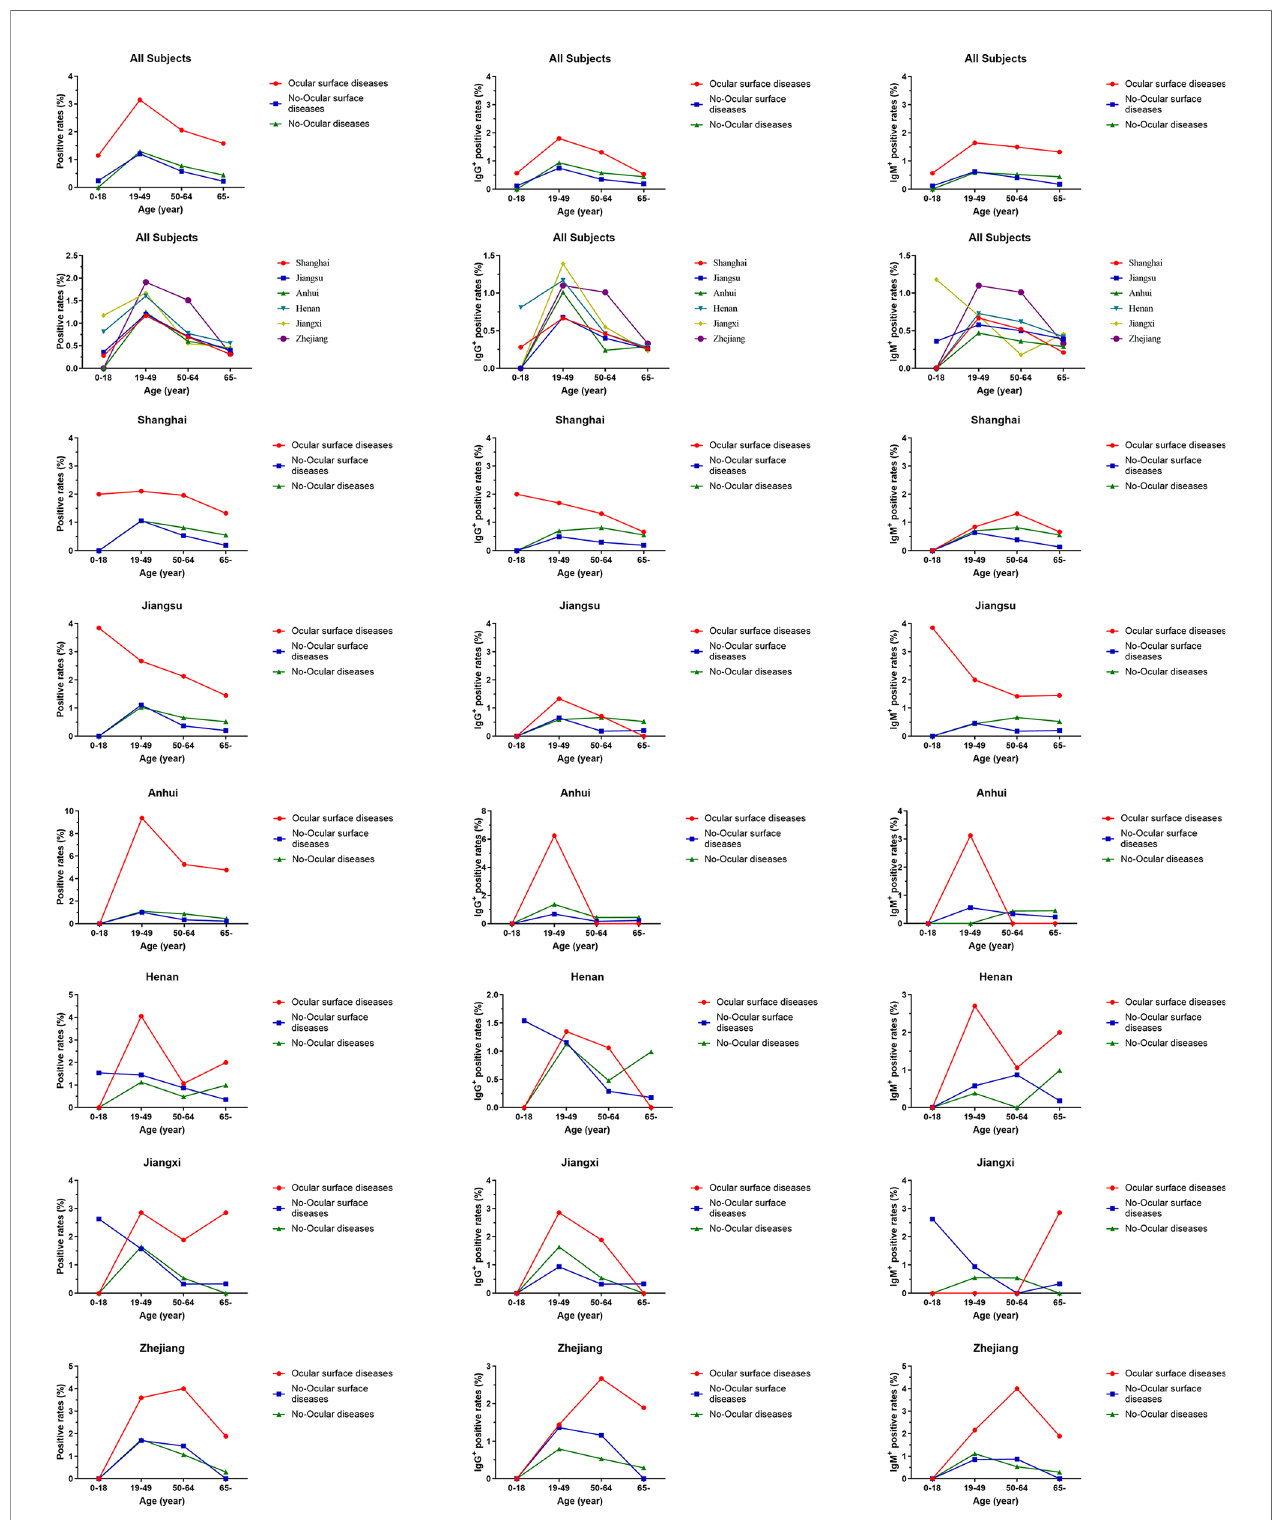
FIGURE 5 | The seroprevalence of antibodies to SARS-CoV-2 in age subgroup. Based on age, all the subjects were further categorized into four subgroups: 0 – 18 years, 19 – 49 years, 50 – 64 years, and >65 years. The seroprevalence of antibodies to SARS-CoV-2 was higher in ocular surface disease with respect to age. A similar result was also observed when SARS-CoV-2 prevalence was compared among ocular surface diseases, no-ocular surface diseases and no-ocular diseases groups in each district.